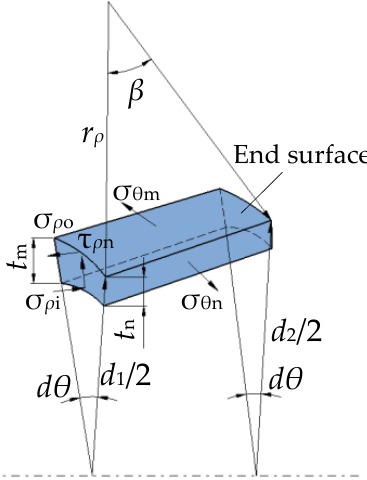
Figure 10. Element body of end warping area.